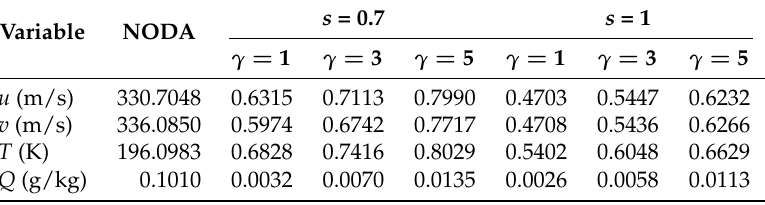
Table 2. Root Mean Square Error (RMSE) values for different values of s and γ .